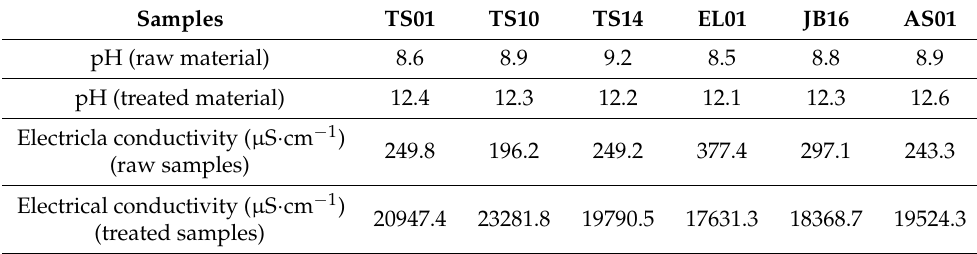
Table 3. pH and electrical conductivity data of the selected sample.